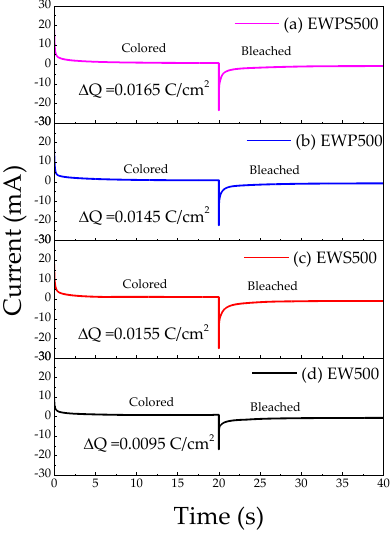
Figure 8. The current curves of different WO 3 films in a cycle of electrochromic test under ±2V voltages: ( a ) EWPS500, ( b ) EWP500, ( c ) EWS500, ( d ) EW500.